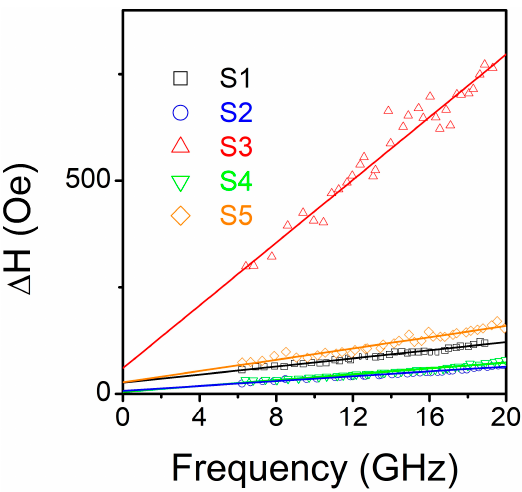
Figure 6. Dependencies of FMR linewidth Δ H as a function of resonance frequency for Co 2 FeGe films deposited at T S = RT (S1), T S = 573 K (S2), T S = 773 K (S3) and deposited at RT and annealed for 1 h at T a = 573 K (S4), T a = 773 K (S5). Experimental data (points) are accompanied by fit (lines) according to Equation (3). Estimated values of damping parameter α are listed in Table 2.